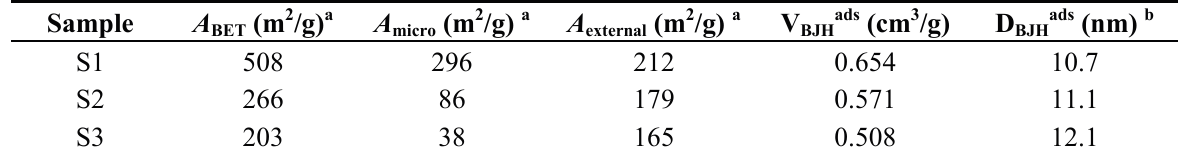
Table 3. Textural properties for the S1, S2 and S3 samples.